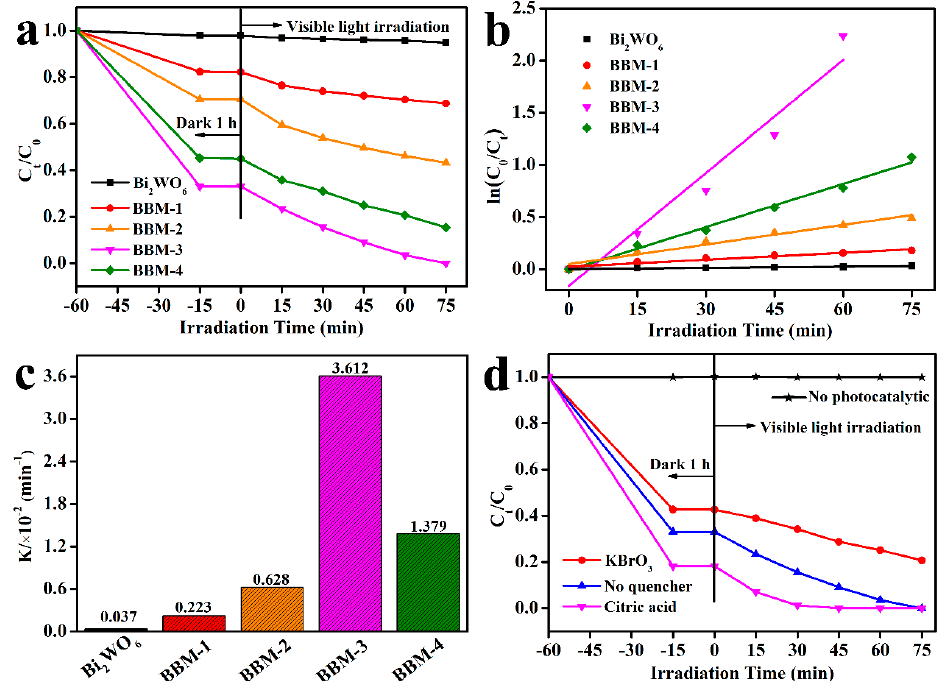
Figure 7. ( a ) Visible light (vis-light) catalytic reduction of Cr(VI) by different catalysts. ( b ) Corresponding pseudo first-order kinetic curves, and ( c ) rate constant “k” by different catalysts. ( d ) BBM-3 vis-light catalytic reduction Cr(VI) in the presence of electron scavengers (KBrO 3 ) and hole scavengers (citric acid), respectively. Dosages of KBrO 3 and citric acid aqueous solutions: 100 µL of 50 mg mL ‒ 1 . Table 2. Performance comparison with other materials used for vis-light catalytic reduction of Cr(VI). Materials/Amount (mg)